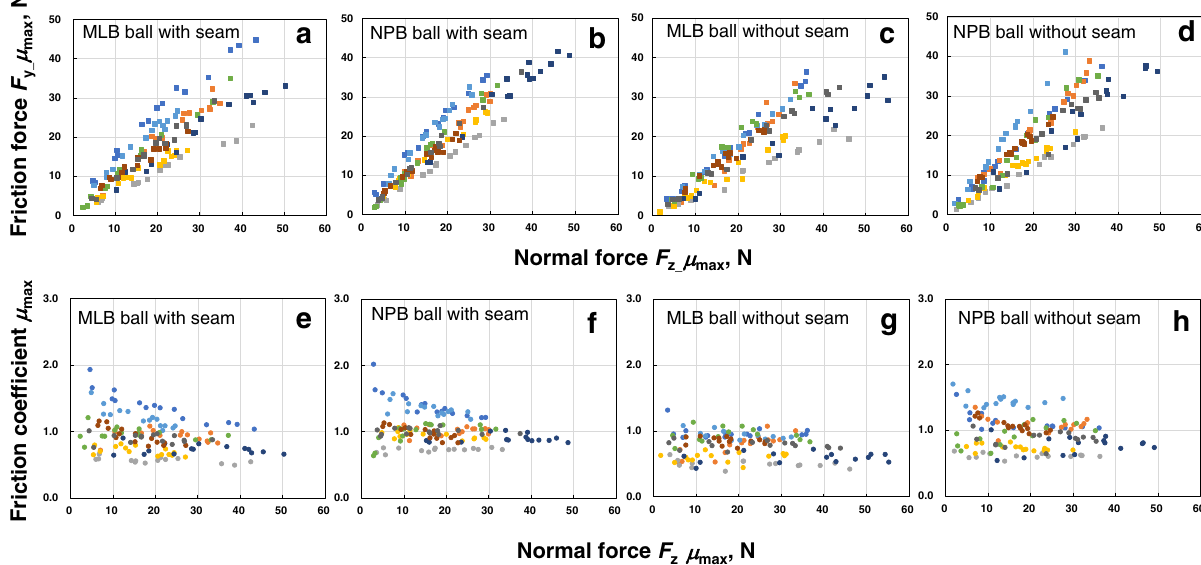
Fig. 5 Frictional characteristics for MLB and NPB balls. a – d Relation between the horizontal force F y _ μ max and normal force F z_ μ max at the instant of each maximum value of the friction coef fi cient µ max for each participant (with different plot color) under no application condition for MLB ball with seam (the same graph as Fig. 2a) ( a ), NPB ball with seam ( b ), MLB ball without seam (the same graph as Fig. 2d) ( c ), and NPB ball with seam ( d ). e – h Relation between µ max and normal force at µ max under no application condition for each participant (with different plot color) under no application condition for MLB ball with seam (the same graph as Fig. 2g) ( e ), NPB ball with seam ( f ), MLB ball without seam (the same graph as Fig. 2j) ( g ), and NPB ball with seam ( h